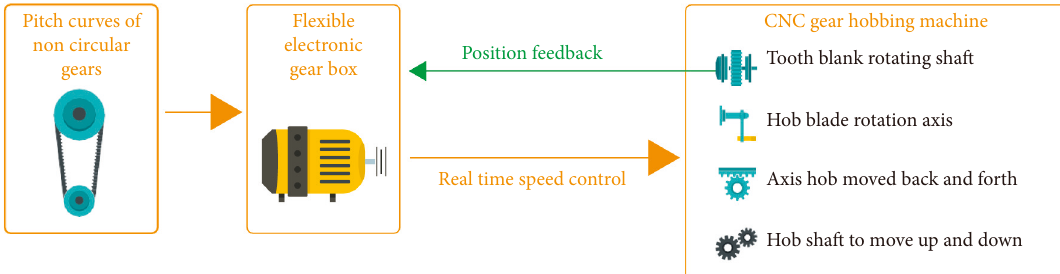
Figure 1: Analysis and research on the accuracy of noncircular gears.